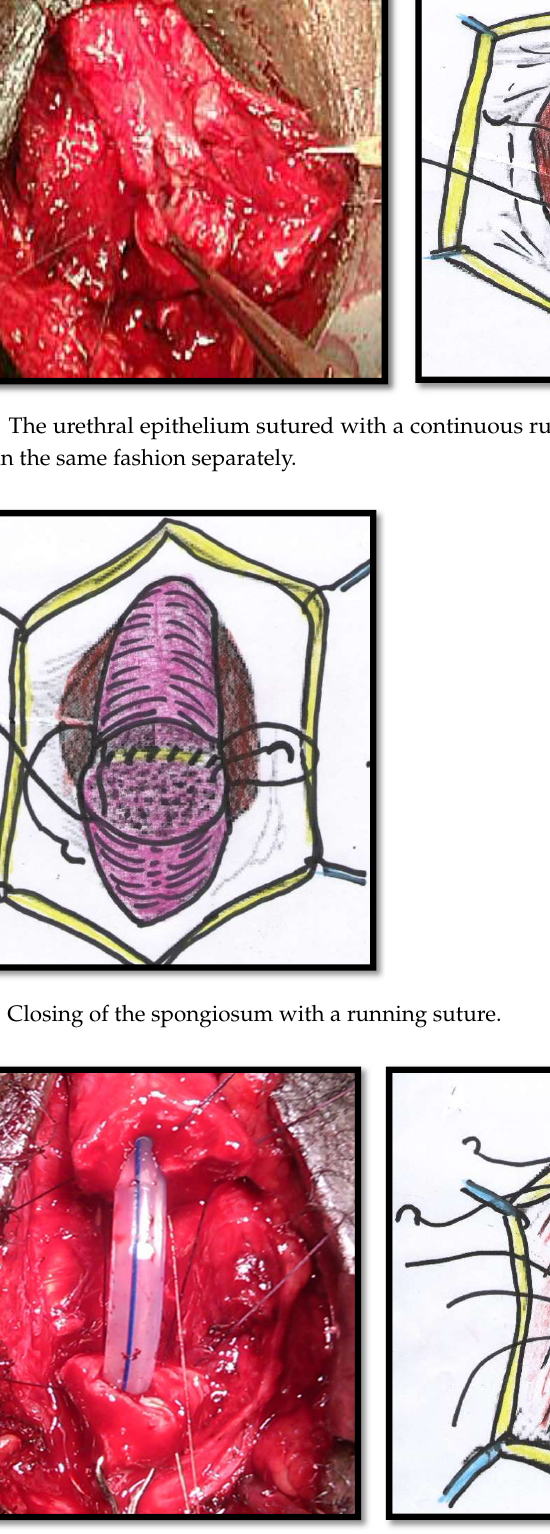
Figure 3. The anastomosis is performed with five interrupted sutures incorporating the epithelium and spongiosum. The urethral catheters of patients in Group 1 were removed on day one and after fourteen days in Group 2. After urethroplasty, RGU was performed at the time of cathe- ter removal, and any occurrence of contrast extravasation was documented. All of the patients were re-evaluated with RUG at six weeks post-operatively. Patients in Group 1 were discharged on day one with saline sitz baths and oral analgesics after urethral catheter removal. The urethral catheters in Group 2 were removed 14 days following surgery. All of the patients were then followed up at a 3-month interval for an 18-month period with a focus on the detailed history of urethral stricture recurrence. Success was defined as no need for subsequent dilatation or any adjunctive endoscopic instrumenta- tion. Statistical Analysis The Student’s test was used to compare age and length. The categorical data were analyzed with the chi-squared test and Fisher’s exact test. Differences were regarded as significant with p ≤ 0.05. All of the calculations were conducted with SPSS ® release 15. (SPSS Inc, Chicago, IL, USA). 3. Results A total of thirty-six patients with a mean age of 45.5 years (range 20 to 69) with bulbar urethral stricture were included in this study. All of the patients had a history of purulent urethral discharge. Five patients had received treatment for a gonococcal infec- tion elsewhere prior to referral to our institution, and thirty-one patients were diagnosed and treated for confirmed gonococcal infection at our institution. The mean stricture length, as assessed by RUG, was 1.20 cm (range 0.6 to 2) in Group 1, and 1.27 cm (range 0.5 to 2.4) in Group 2, respectively ( p = 0.631) (Table 1). The overall success rate after an 18-month minimum FU period for Group 1 was 90% com- pared to the 71% in Group 2 ( p = 0.2185; CI 95%; 0.4628 to 41.5756).